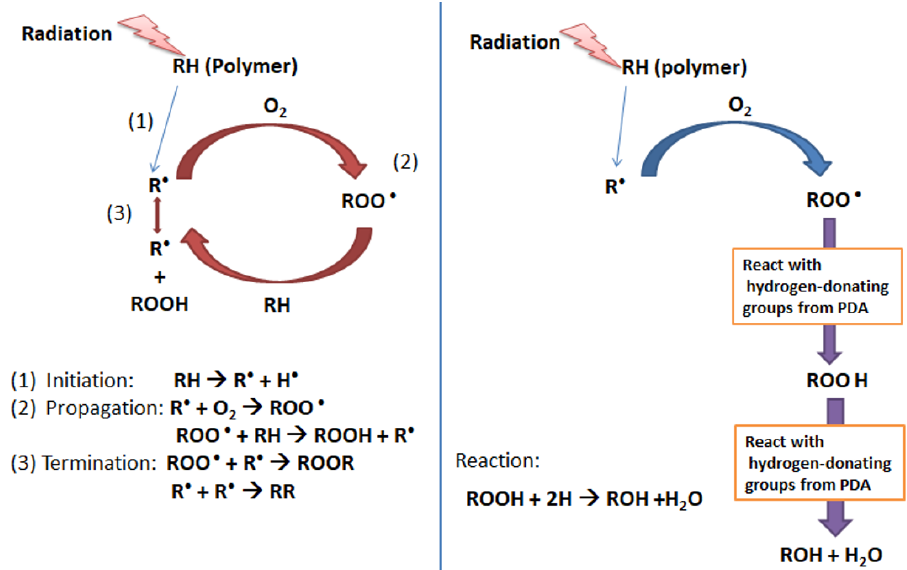
Figure 11. Proposed scavenging mechanism of a UV-induced radical by PDA: ( left ) photodegradation mechanism of the polymer and ( right ) proposed mechanism of free-radical scavenging by polydopamine.